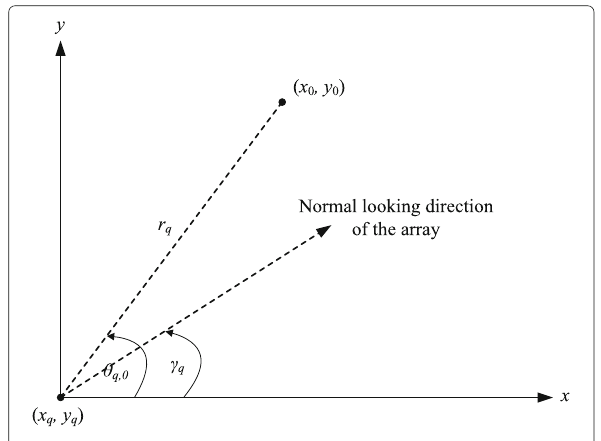
Fig. 1 Illustration of geometrical reference model. Illustration of geometrical reference model of ( x 0 , y 0 ), ( x q , y q ), ( r q , θ q ,0 ), and γ